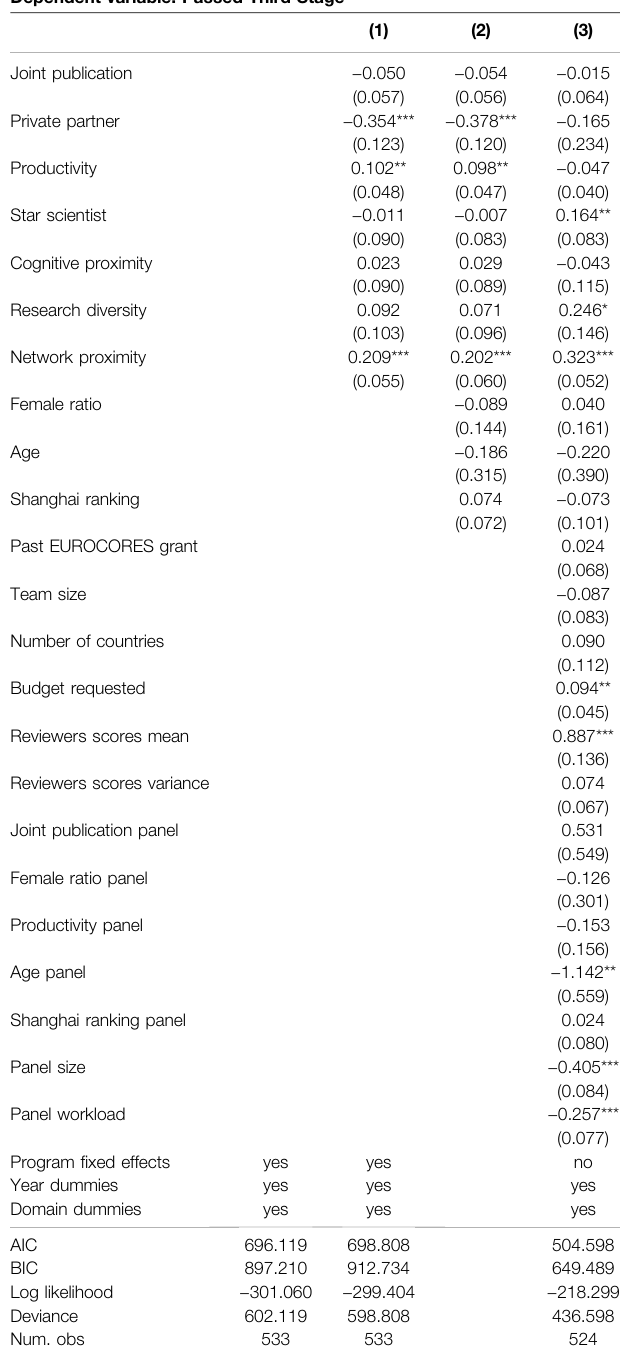
TABLE 10 | Third Stage — Probit regression